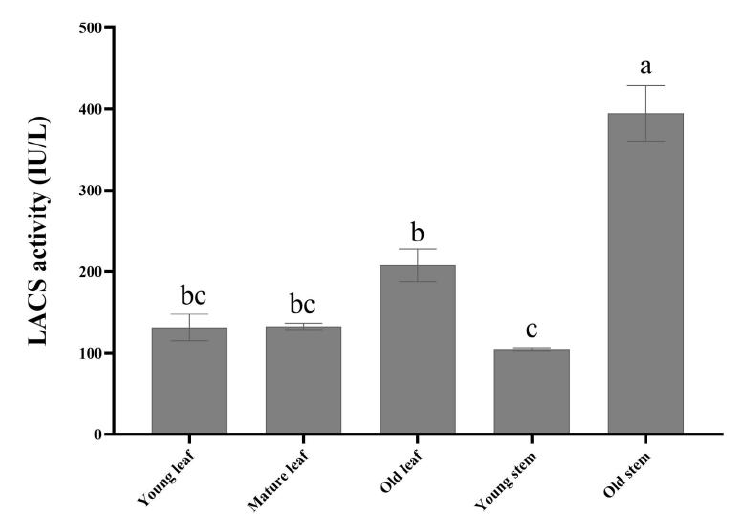
Figure 3. LACS enzyme activity from leaves and stems under drought.